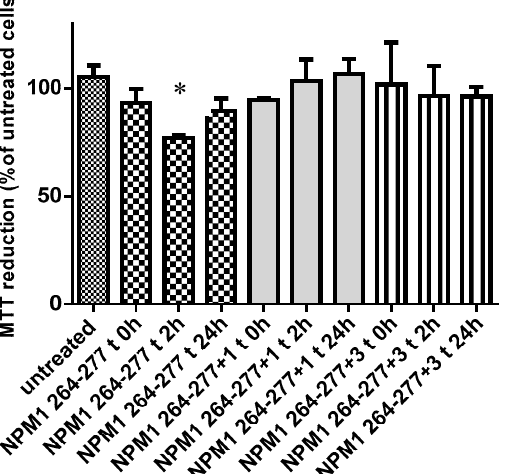
Figure 9. MTT assay in SH-SY5Y cells treated with NPM1 264–277 and NPM1 264–277 :Pt compounds at 1:10 peptide to metal compounds molar ratio under stirring at three different times, 0, 2 and 24 h, * p < 0.05 in statistical analysis.